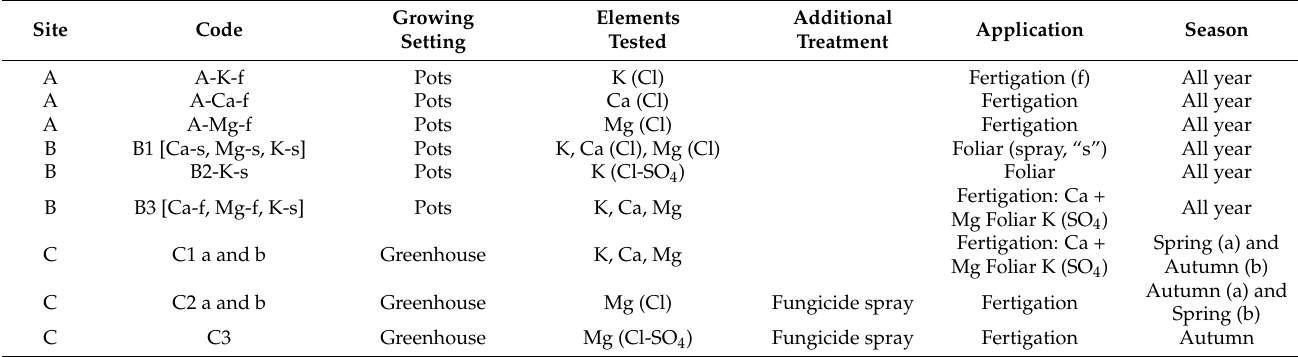
Table 1. Experimental setup, factors tested, application methods and growing seasons 1